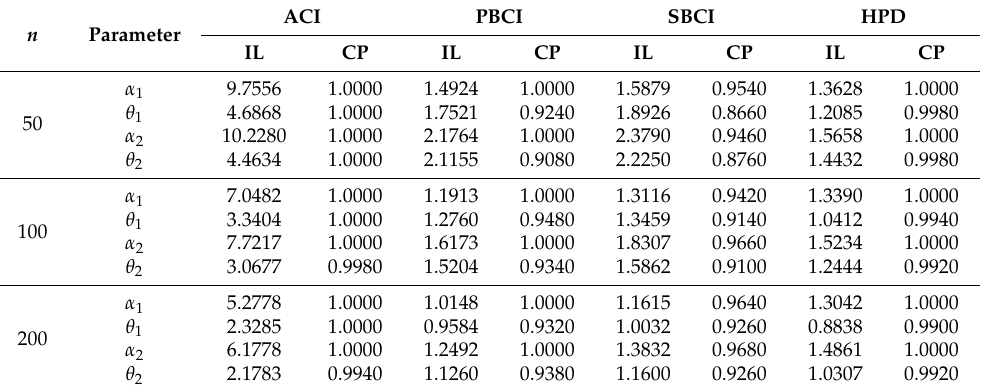
Table 4. Interval estimates of ( α t , θ t ) , t = 1,2 under Scheme 1.